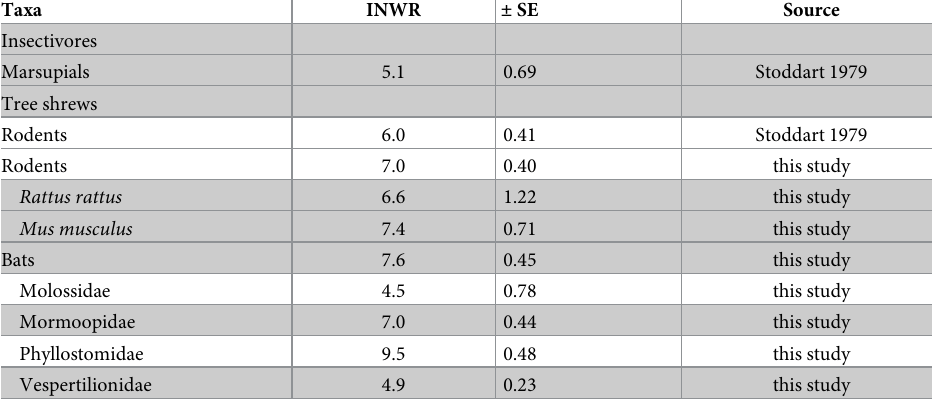
Table 3. Average inner nostril width ratios (INWR) and standard error (SE) for a sample of mammalian